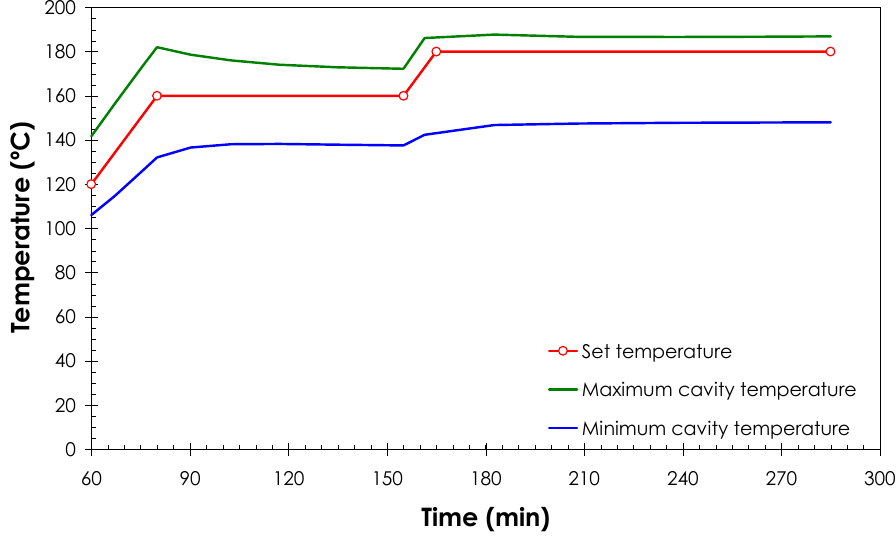
Figure 15. Evolutions of the maximum and minimum temperatures of the cavity.